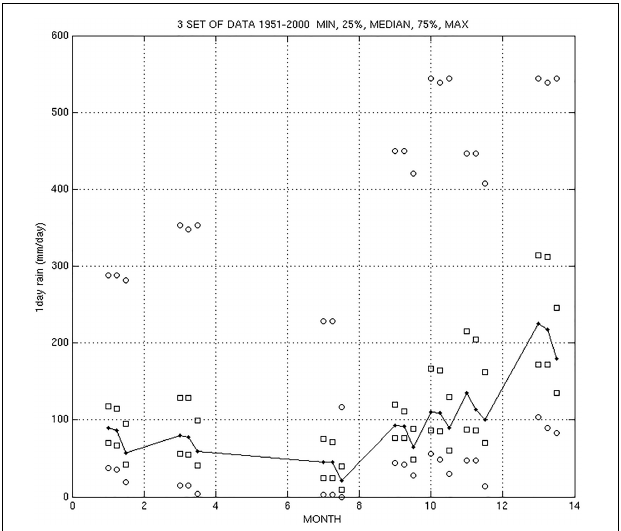
FIGURE 8 | Summary of three data set. Minimum, 25%, median, 75%, maximum for January, March, July, September, October, November, and yearly